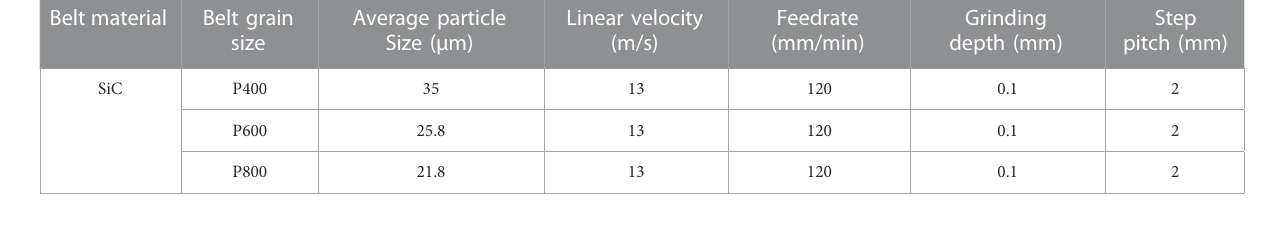
TABLE 2 Grinding process parameters for the experiments. Belt material